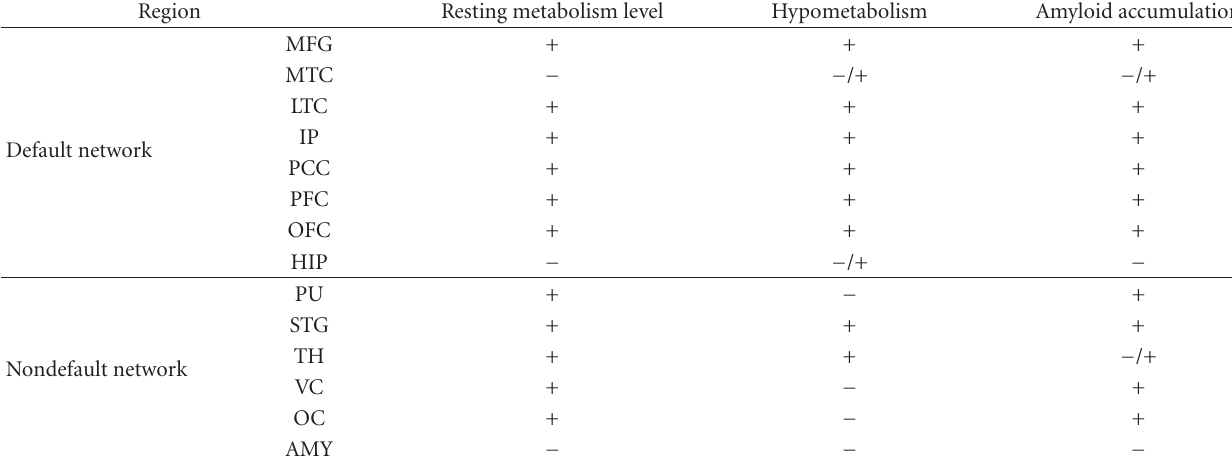
Table 3: Comparison of the patterns of resting glucose metabolism, glucose hypometabolism, and amyloid deposition in the default and nondefault networks. Region Resting metabolism